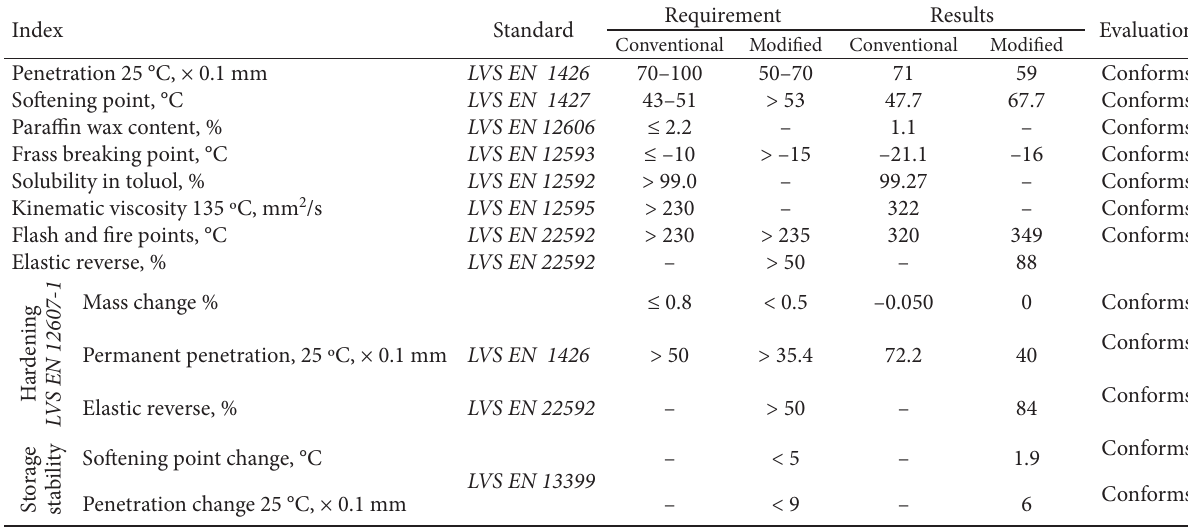
Table 2. Evaluation of the bitumen B 70/100 conformity to requirements of the Standard LVS EN 12591:2000 Bitumen and Bituminous Binders – Specifications for Paving Grade Bitumens